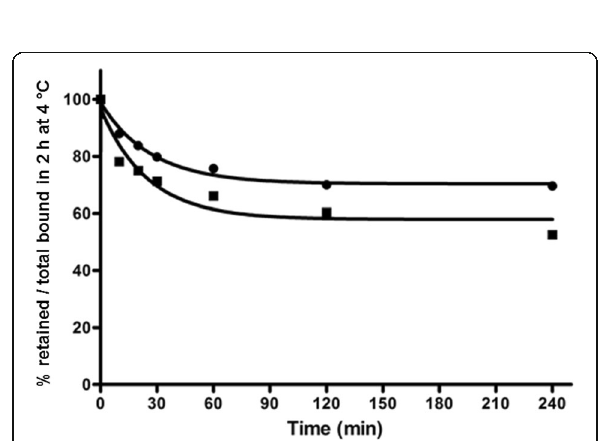
Fig. 4 Dissociation kinetics of the cell surface bound radioligands on HEK293-rsst2 cells. Dissociation kinetics of membrane bound 177 Lu-SS-03 (circle) and 99m Tc-SS-04 (square) as measured with HEK293-rsst2 cells. The profile illustrates the varying degree of dissociation kinetics exhibited by 177 Lu-SS-03 (koff=0.037 min -1 and t1/2=18.66 min) and 99m Tc-SS-04 (koff=0.040 min -1 and t1/2=17.24 min). Values and standard